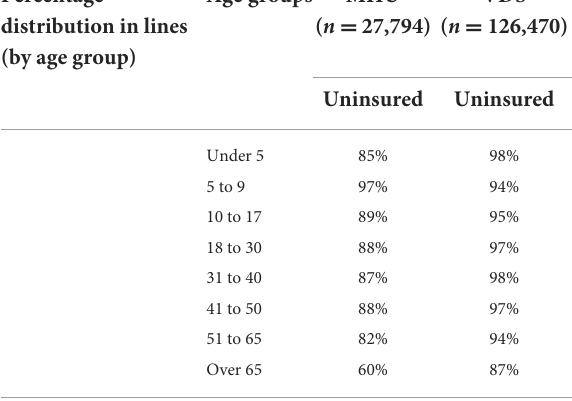
TABLE 4 Percentage distribution (in lines and columns) of population served at VDS and MHU by age group and medical insurance status, January 2019—December 2021.